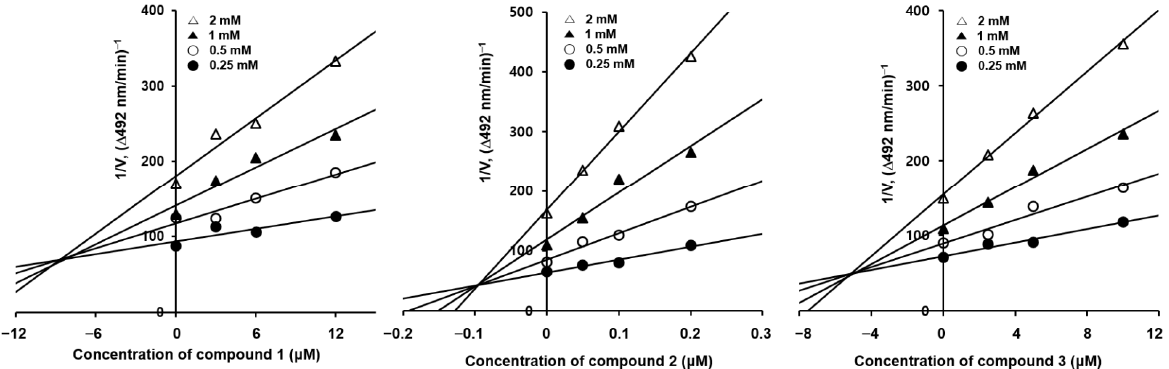
Figure 3. Dixon plots for the inhibition of mushroom tyrosinase activity by ( Z )-BPT derivatives 1 – 3 . The K i values of ( Z )-BPT derivatives 1 – 3 were obtained from the absolute values of the x-coordinate where four straight lines converged at one point. Three independent experiments with four different concentrations of ( Z )-BPT derivatives were conducted to measure the augmented dopachrome optical density per minute at 492 nm. The data are shown as the mean values of 1/V (an inverse of that optical density per minute). The ( Z )-BPT derivatives were used at concentrations of 0, 3, 6, and 12 µM for 1 ; 0, 0.05, 0.1, and 0.2 µM for 2 ; and 0, 2.5, 5, and 10 µM for 3 . The experiments were performed at four different concentrations (0.5, 1, 2, and 4 mM) of L -DOPA. Each experiment was run independently in